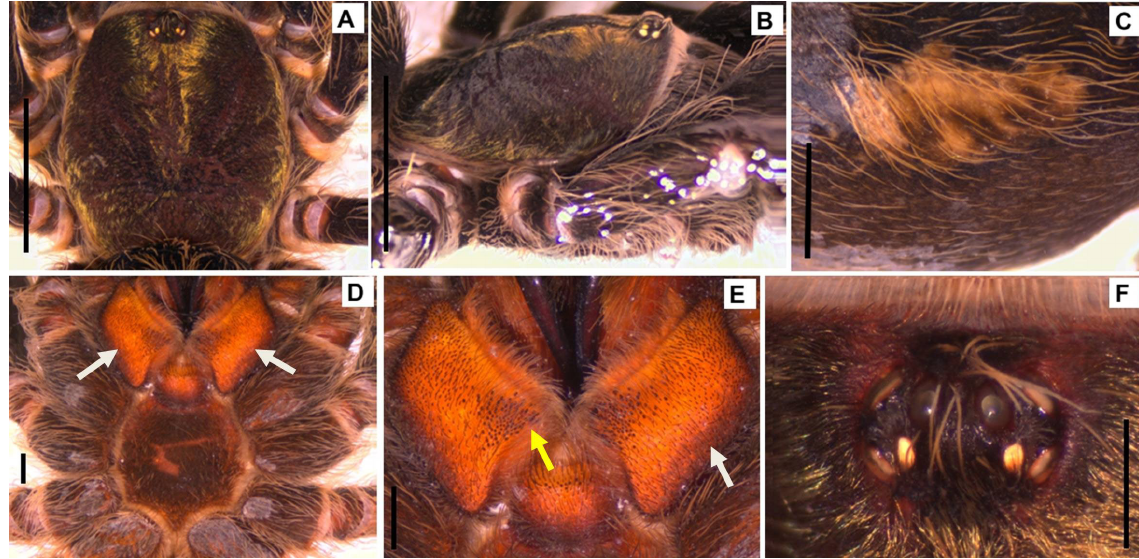
Fig. 6. Bistriopelma peyoi sp. nov., paratype, ♀ (MUBI 70). A . Carapace, dorsal view. B . Carapace, lateral view. C . Urticating setae patch. D . Sternum, labium and maxillae, ventral view, white arrows indicate the dark pubescence in the basal maxillae. E . Labium and maxillae, ventral view (the yellow arrow indicates the basal tubercle with cuspules well developed and the white arrow indicates the dark pubescence in the basal maxillae). F . Eyes. Scale bars: A–B = 5 mm; C–F = 1 mm.